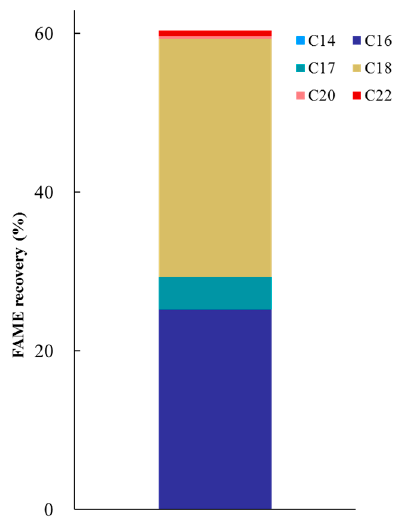
Figure 4. Compositions of FAME obtained under optimal conditions for sequential extraction.